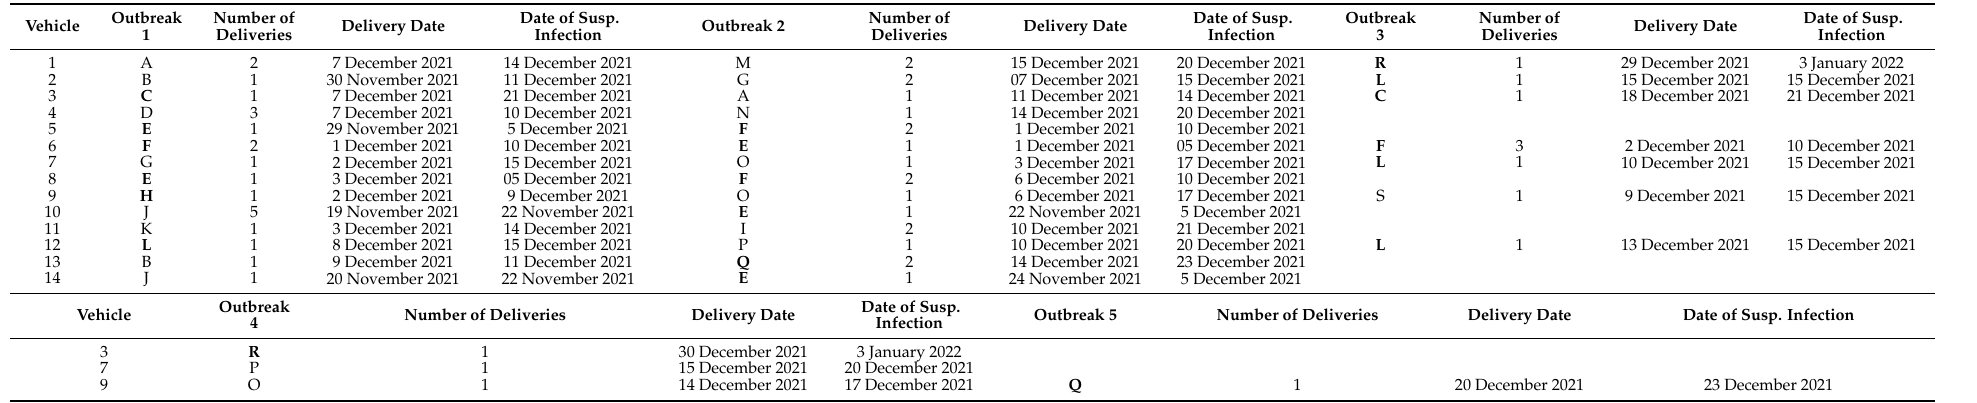
Table 3. High-risk contact between HPAI outbreak sites in the province of